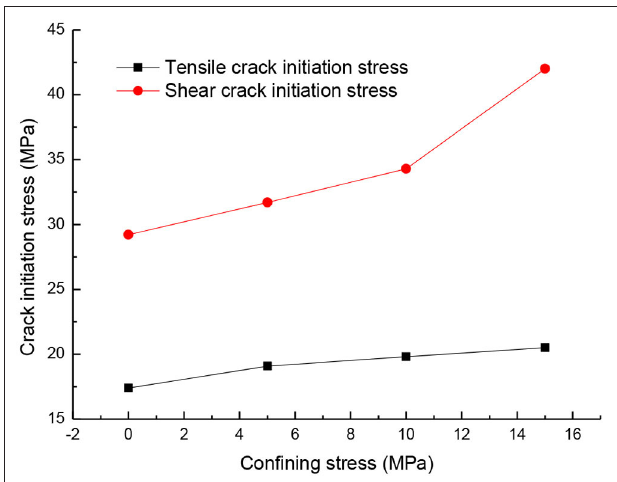
FIGURE 12 | The tensile and shear crack initiation stresses.